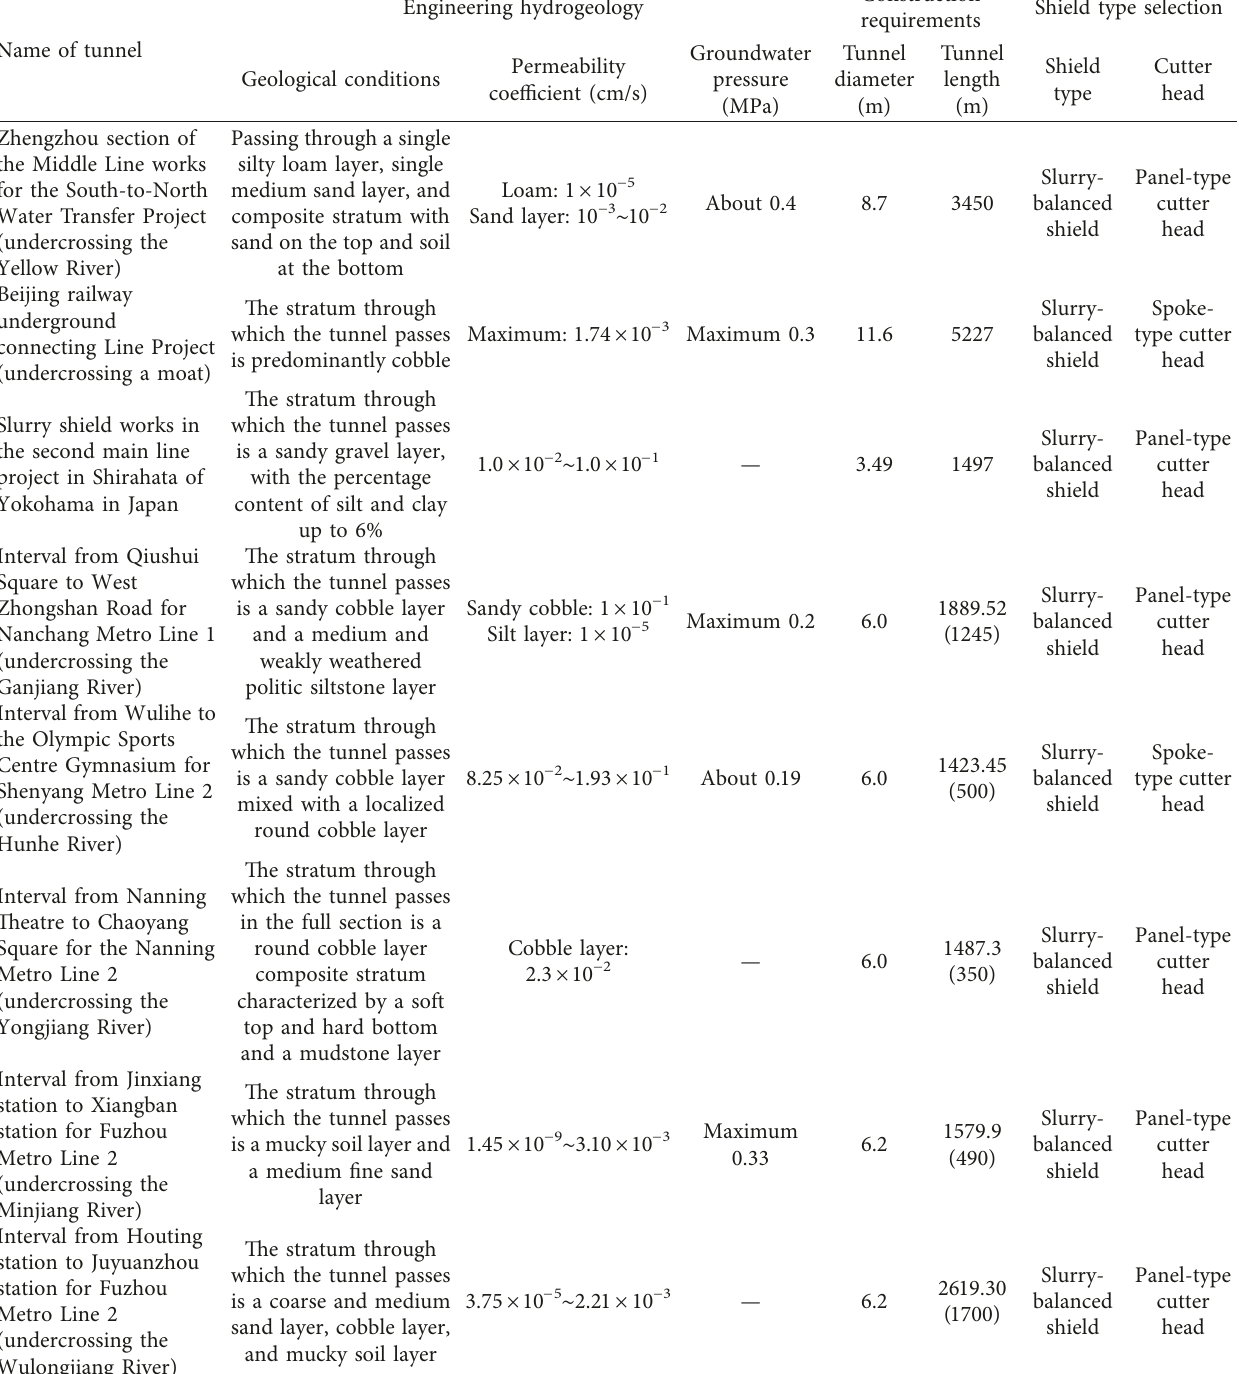
Table 2: Comparison of similar engineering projects.